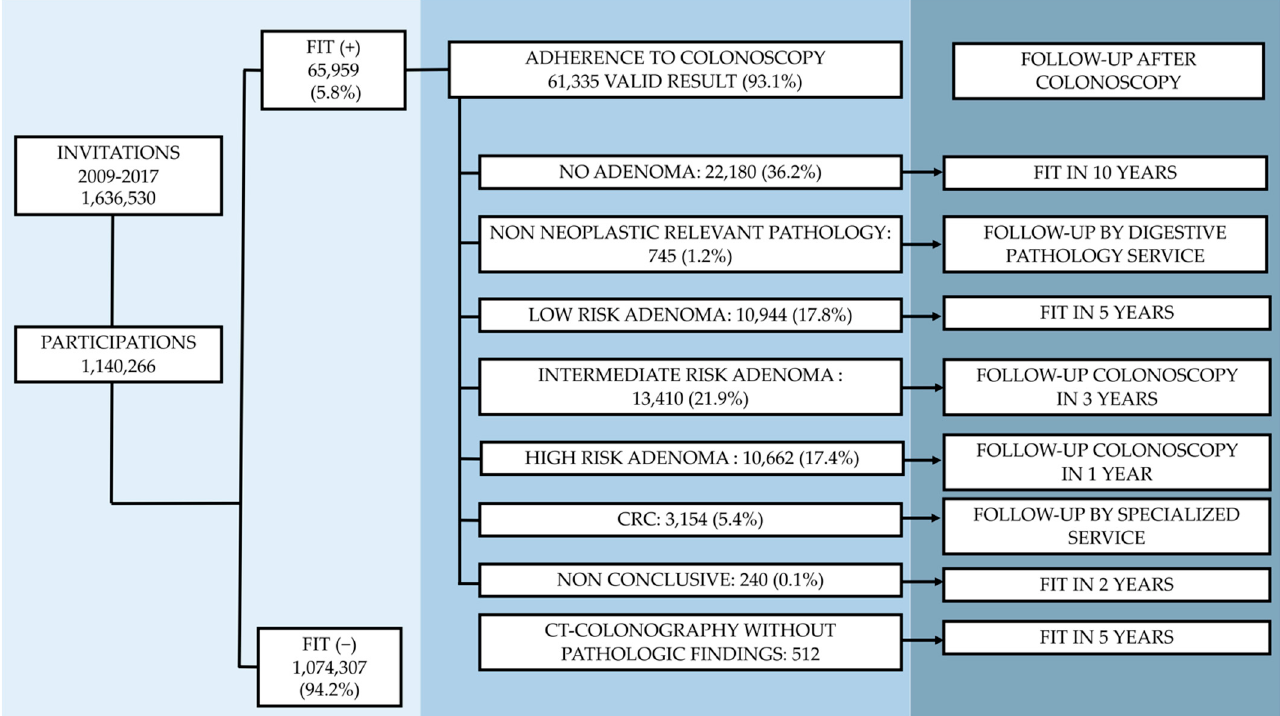
Figure 1. Findings in the colonoscopies carried out, and corresponding recommended surveillance according to the European Guideline for Quality Assurance in Colorectal Cancer Screening and Diagnosis and the consensus of the Spanish Cancer Screening Network [9,23].